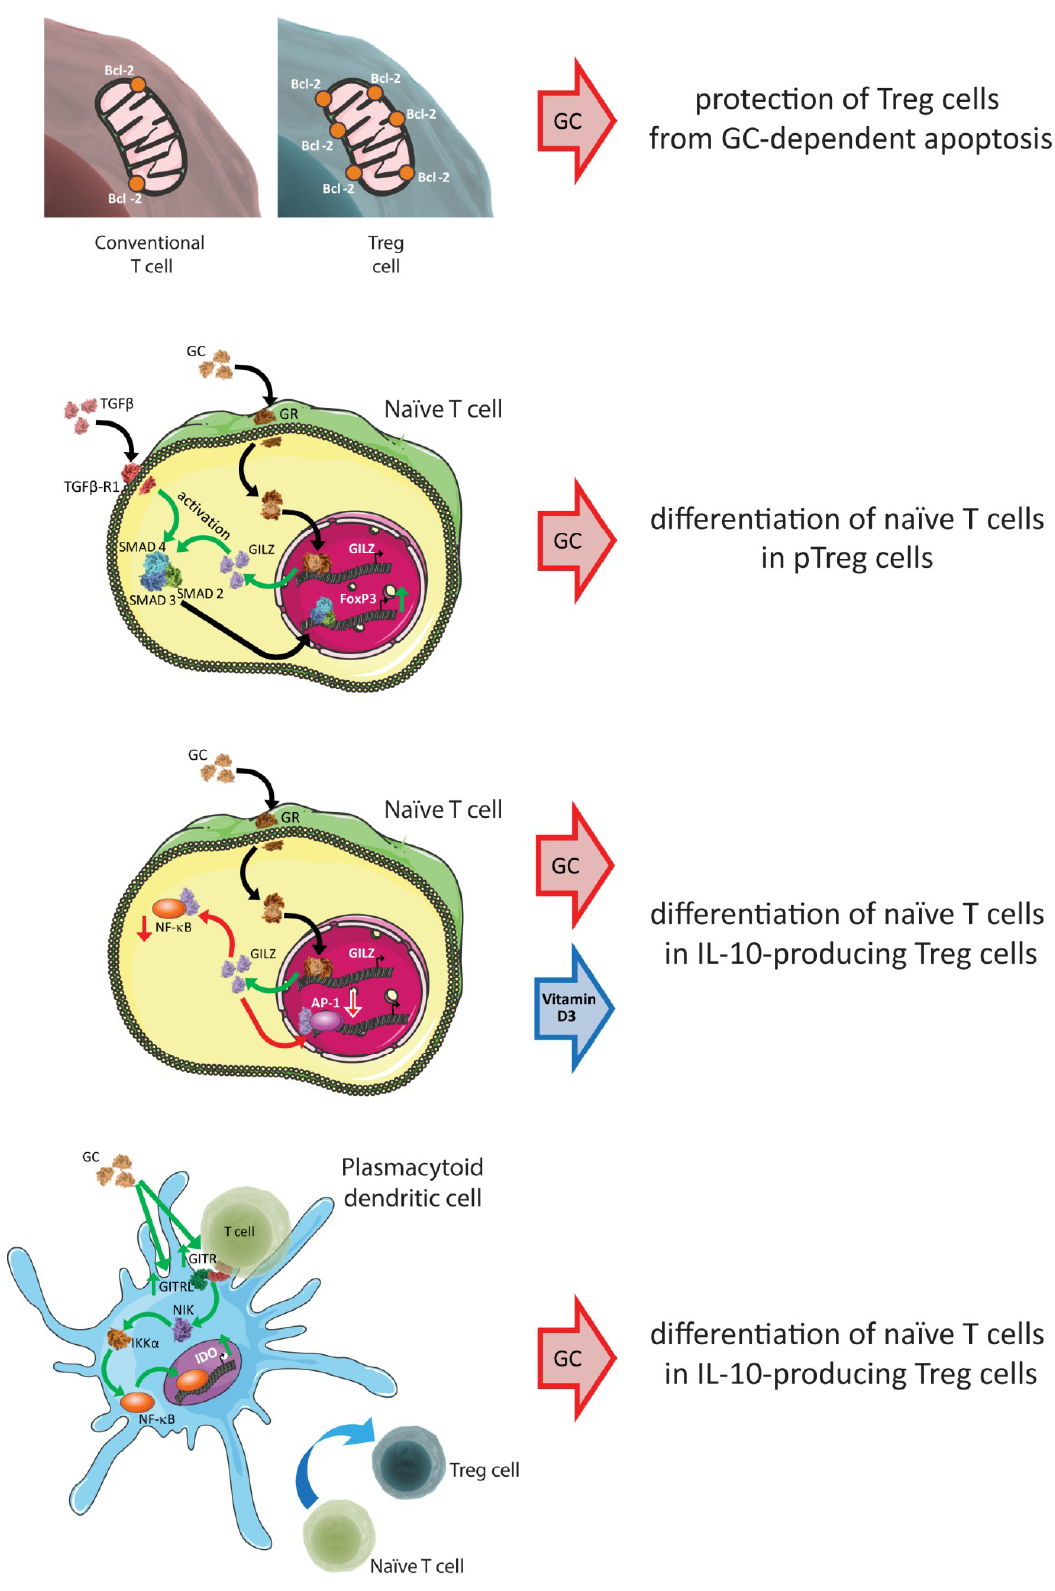
Figure 2. Key signaling molecules determining Treg cell survival/expansion/differentiation. The figure summarizes the key mechanisms by which GC treatment increases the number of Treg cells, which are described in detail in Section 8 of this review. Mechanisms include the increased expression by Treg cells of anti-apoptotic signals (upper panel), and the modulation of pathways in naïve T cells (middle panels) and non-T cells (lower panel). Red arrows indicate decreased expression and inhibition; green arrows indicate increased expression and activation.